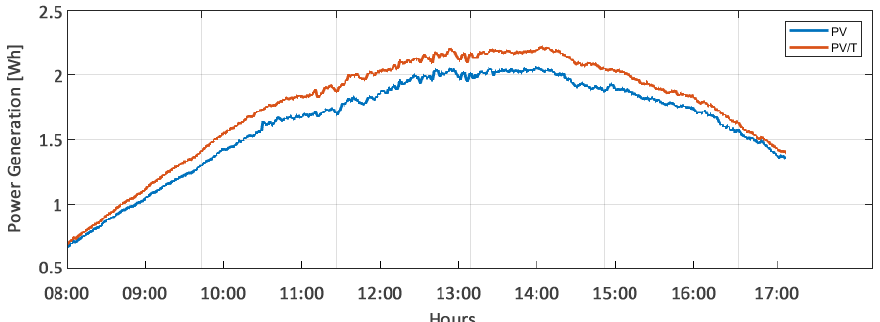
Figure 8. Hourly power generation of the PV and PV/T